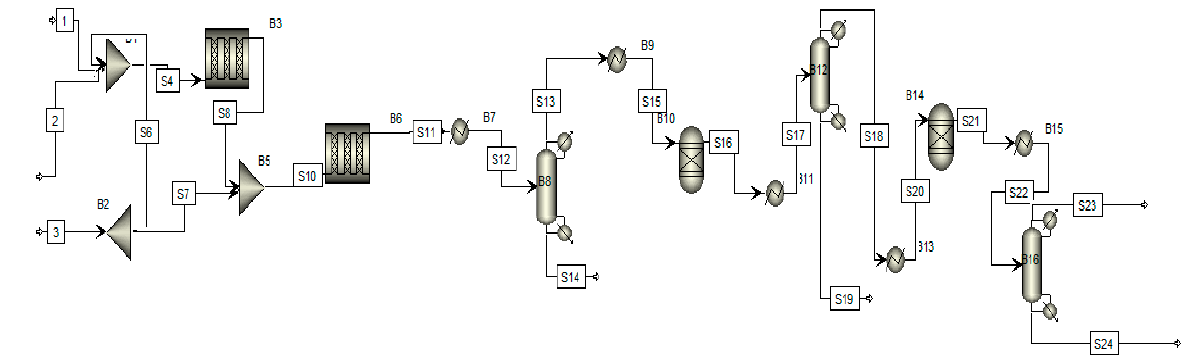
Figure 2. Process flow diagram of the Claus process.